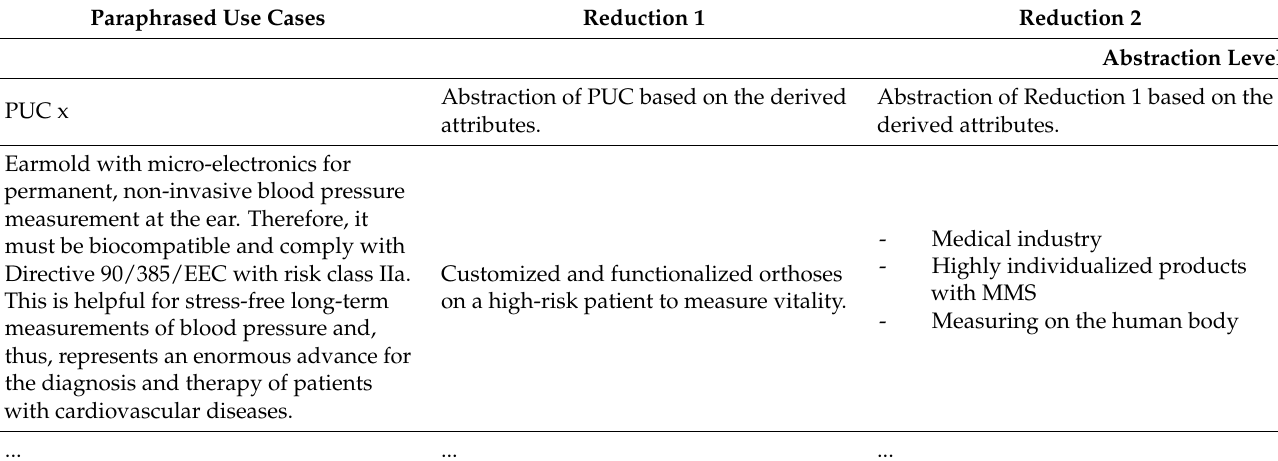
Table 2. Qualitative content analysis of the PUC with the derived attributes—area of application, product and functions— with one example in Line 2.